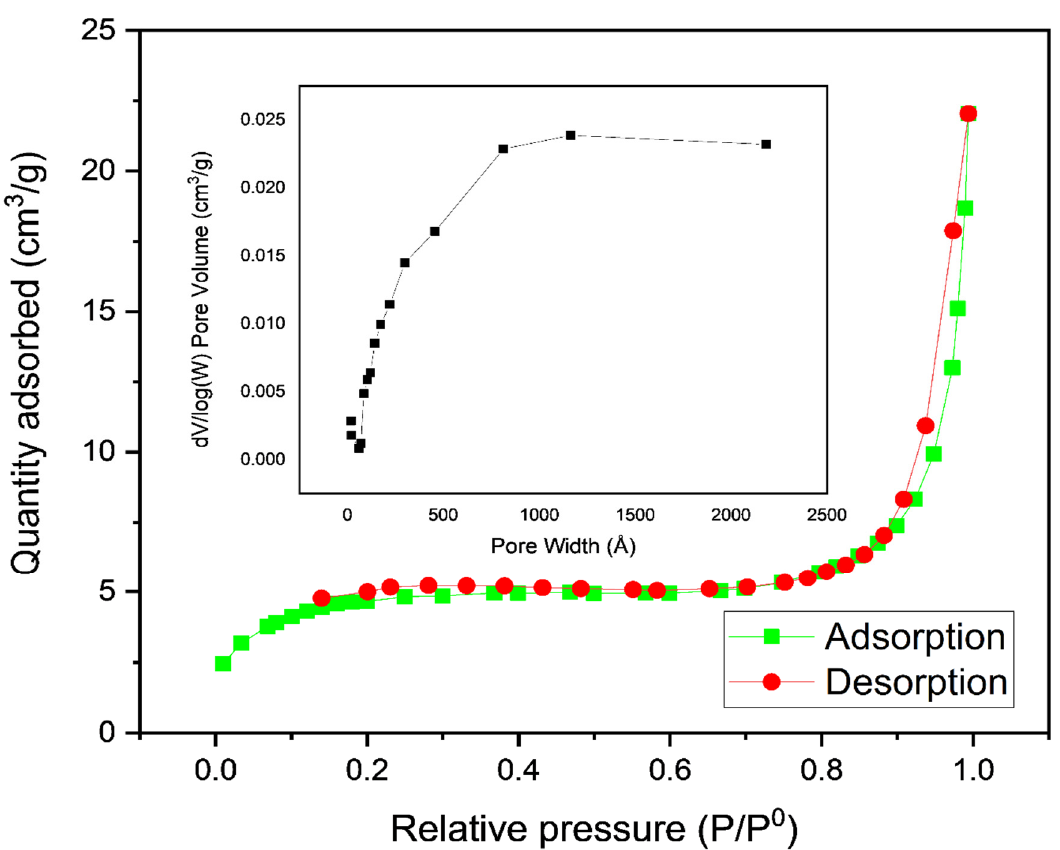
Figure 4. BET isotherms of Polypyrrole ‐ Polyethyleneimine for the adsorption–desorption of N 2